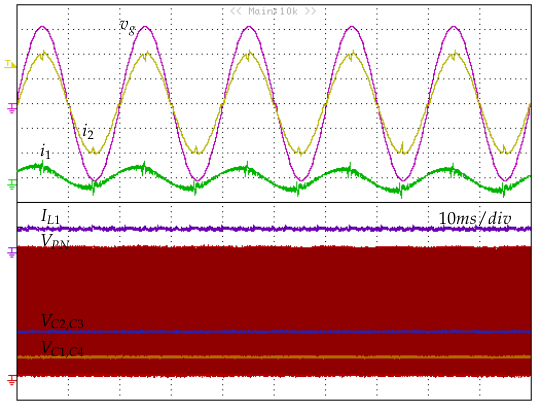
Figure 9. Experimental results when K v = 0.15 ( i 1 = 20 A/div, i 2 = 5 A/div, v g = 100